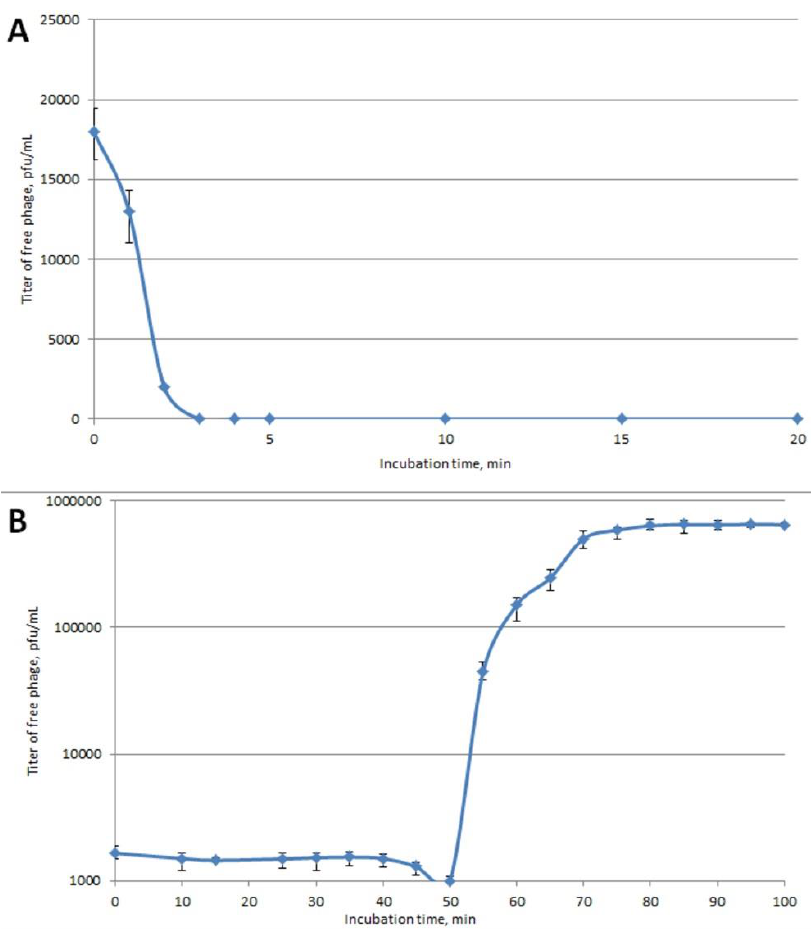
Figure 1. ( A ) Adsorption of phage Arno 160 to host bacteria. ( B ) One step growth curve of Arno 160 using P. carotovorum F160 as a host.